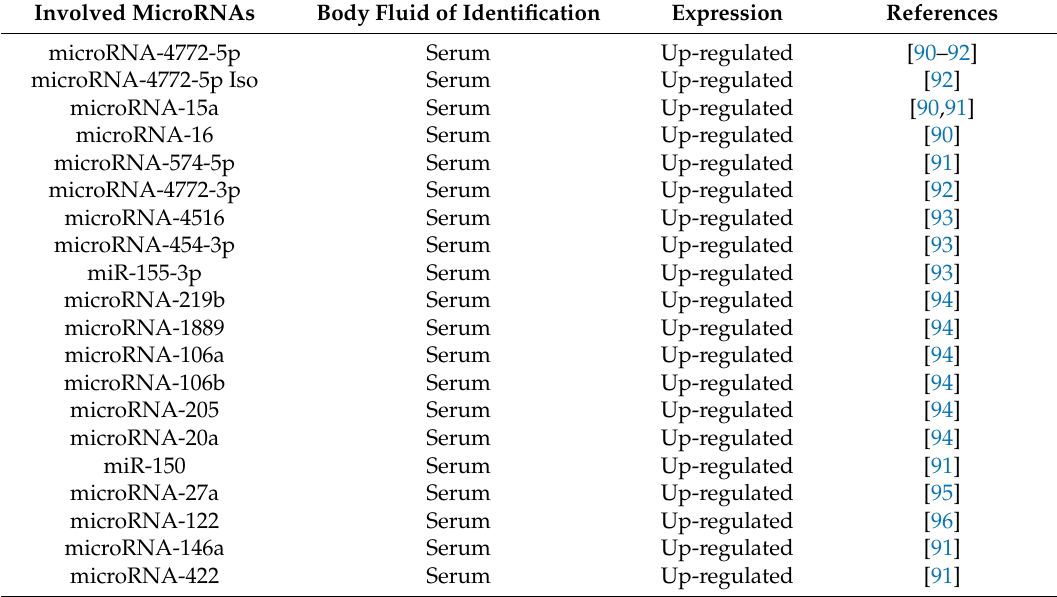
Table 1. MicroRNA expression in